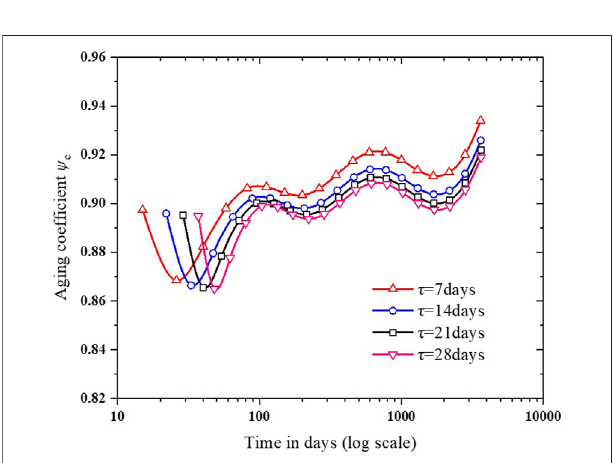
FIGURE 12 | Aging coef fi cient with increasing loading age.